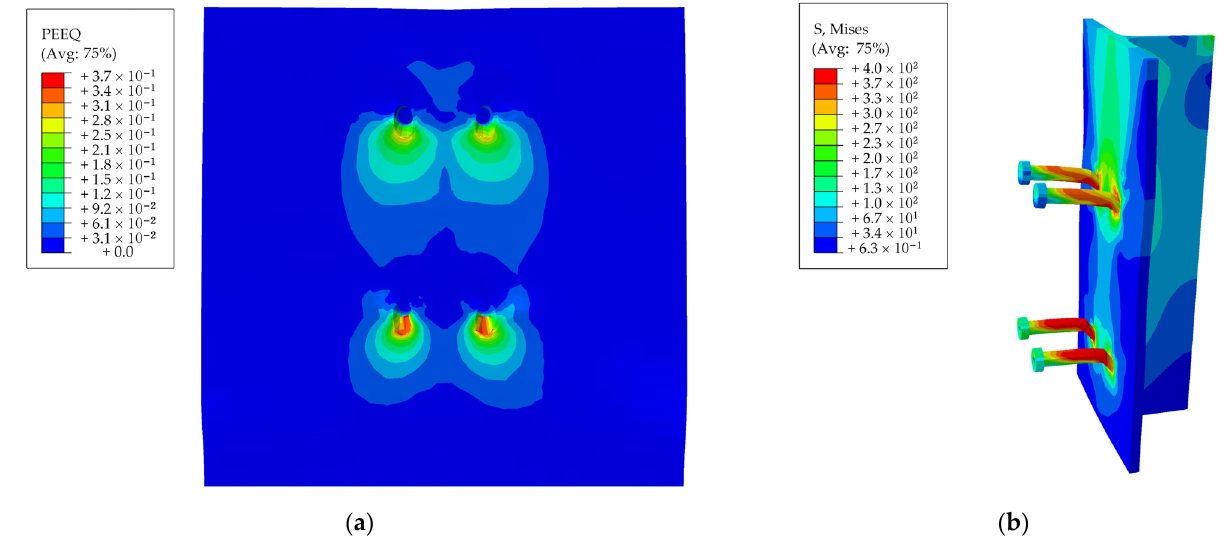
Figure 10. Results obtained from FE simulations: ( a ) concrete slab; ( b ) steel beam and stud.